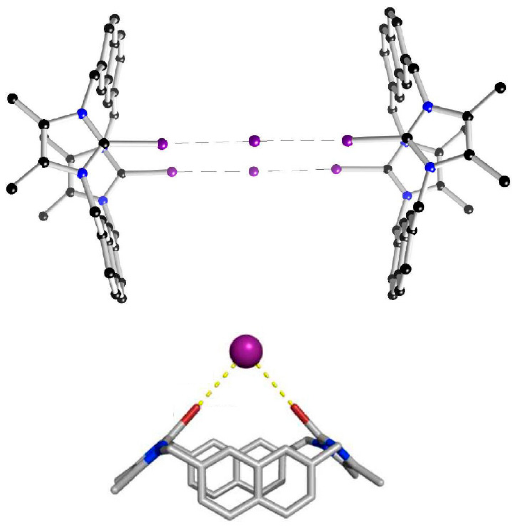
Figure 9. Adapted with permission from reference [106]. (Top) Dimeric crystal structure of iodo-imidazolium (PF 6 − and hydrogens are omitted for clarity) and (bottom) density functional theory (DFT) structure of the monomeric structure present in solution. Copyright 2012 American Chemical Society.